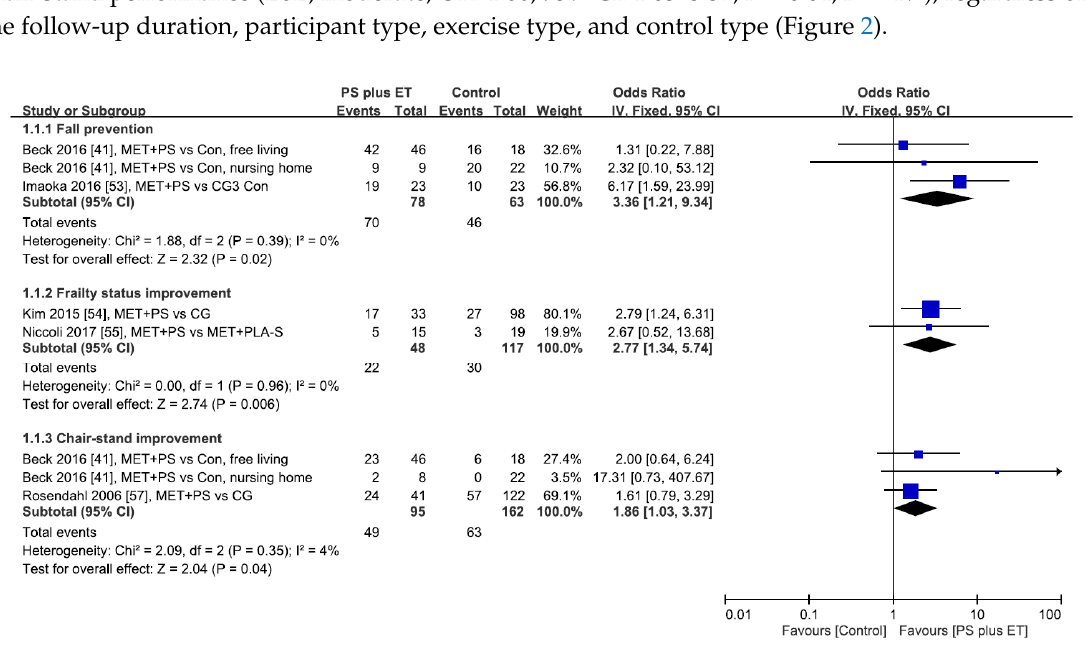
Figure 2. Forest plot of treatment success rates of fall prevention, frailty mitigation, and chair-stand improvement during the overall follow-up period. Each study result is represented as a point estimate (square box) with 95% CI (horizontal line). The study results plotted on the right-hand side indicate effects in favor of protein supplementation (PS) plus exercise training (ET), and the combined effects are plotted as black diamonds. 95% CI = 95% confidence interval; IV = inverse variance; Fixed = fixed-effects model; CG = control group; Con = control; MET = multicomponent exercise training; PLA-S, placebo supplement.